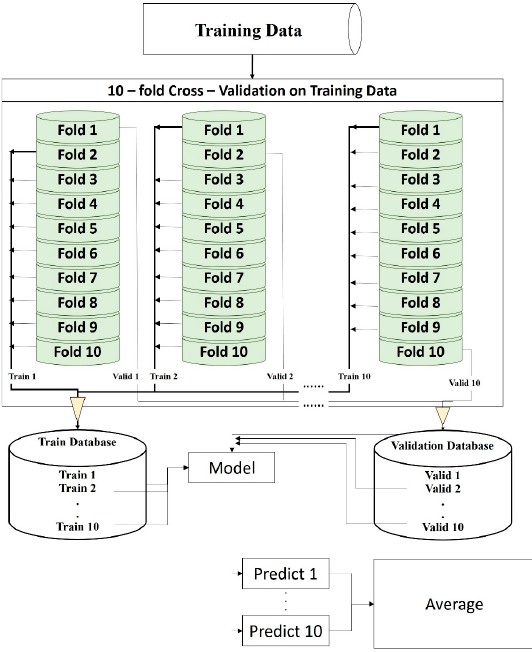
Figure 9. K-fold cross-validation flow chart.